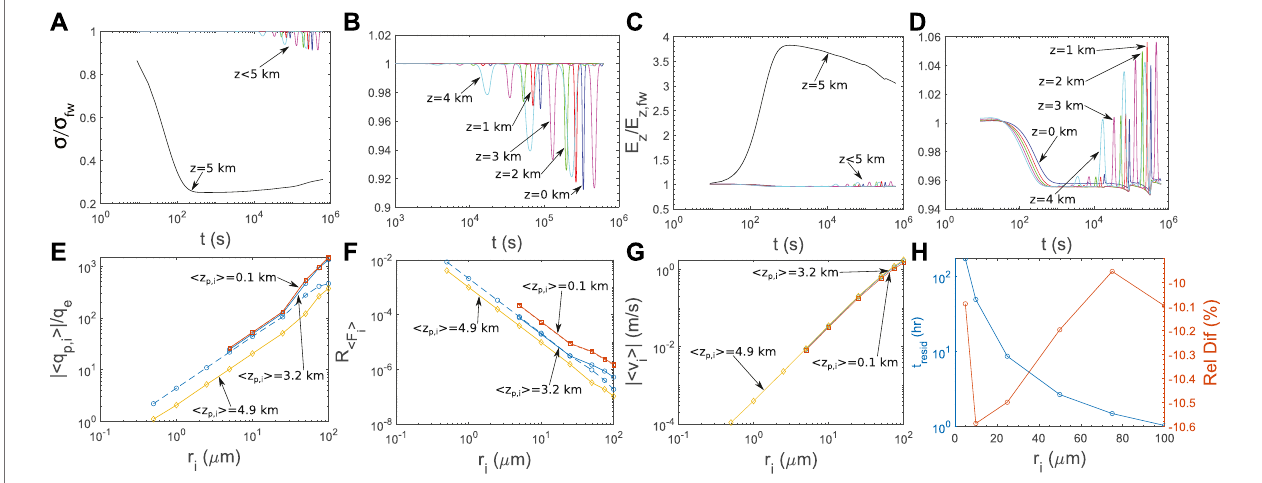
FIGURE 9 | Characteristics of particles distributed along the altitude according to N II p , i : (A) Conductivity reduction with respect to the fair weather value at different altitudesovertime, (B) magni fi cationofpanel(A)intheregion z < 5 km, (C) electric fi eldmagnitudemodi fi cationwithrespecttothefairweathervalueatdifferentaltitudes overtime, (D) magni fi cationofpanel (C) intheregion z < 5 km, (E) averagenumberofelementarychargesperparticleasafunctionofparticleradiusfordifferentaverage bin distribution altitudes, (F) ratio between average electrical force magnitude and gravity magnitude as a function of particle radius for different average bin distribution altitudes, (G) average particle velocity as a function of particle radius for different average bin distribution altitudes, (H) residual time of particles in the atmosphereuntil99.9%oftheirconcentrationislost,andrelativedifferencewiththeresultsof N